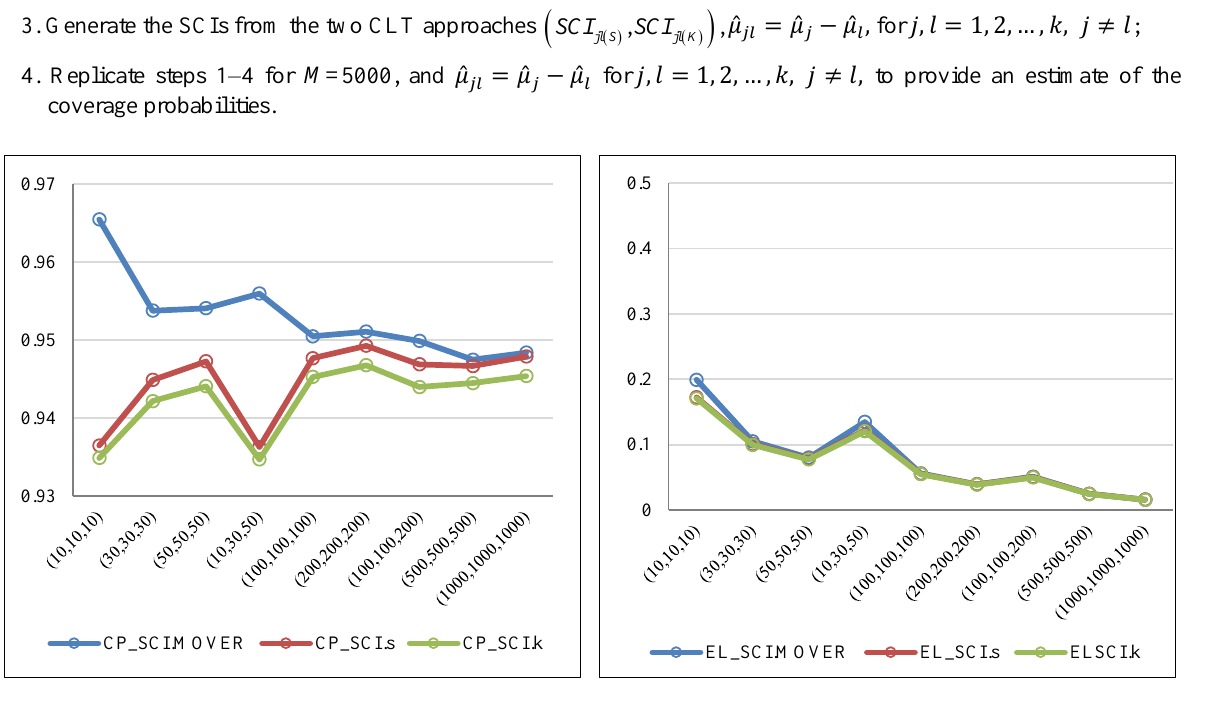
Figure 1. The CP and the EL of the 95%two-sided SCIs for the means of normal distributions with known CVs: (𝝉 ) = (0.1,0.1,0.1), 3 sample cases (𝒏 𝟏 , 𝝉 𝟐 , 𝝉 𝟑